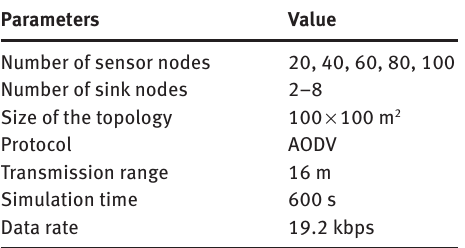
Table 1: Simulation